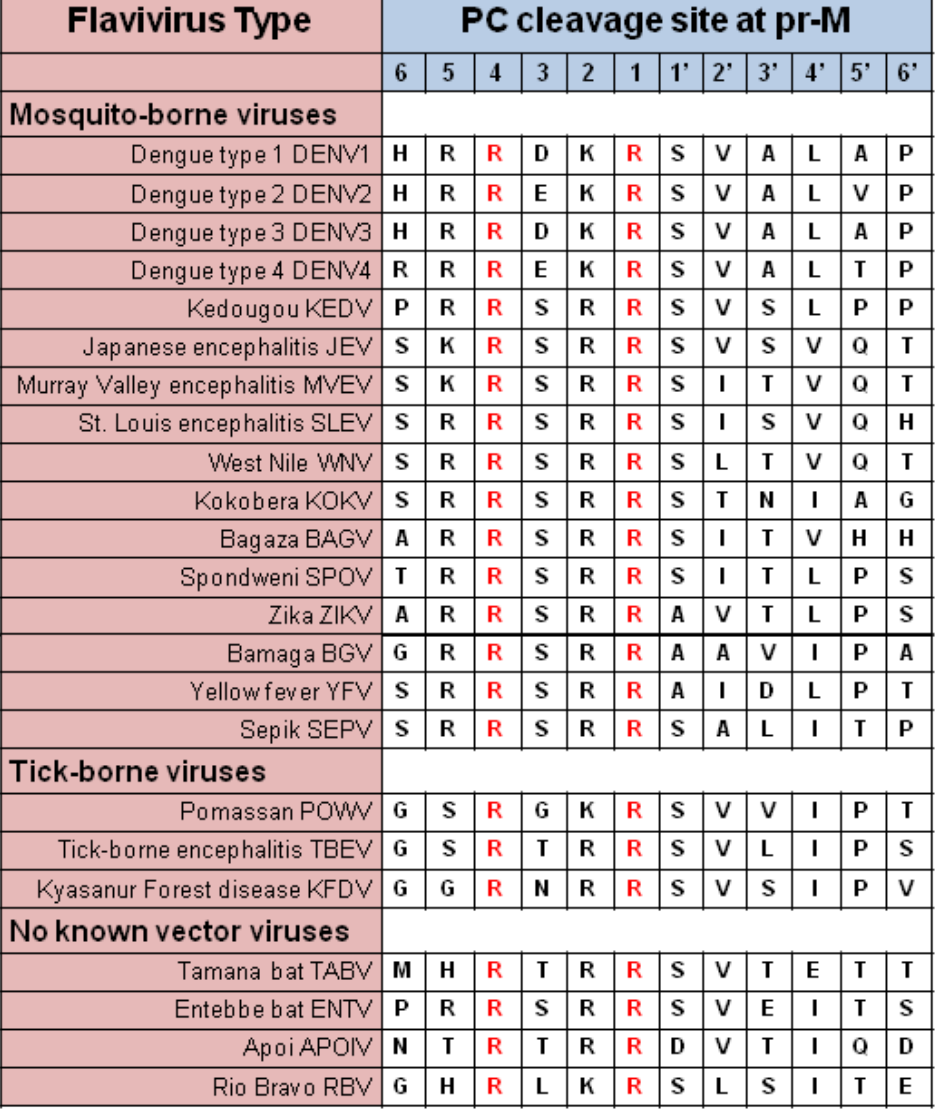
Table 4 . Alignment of flavivirus PC cleavage